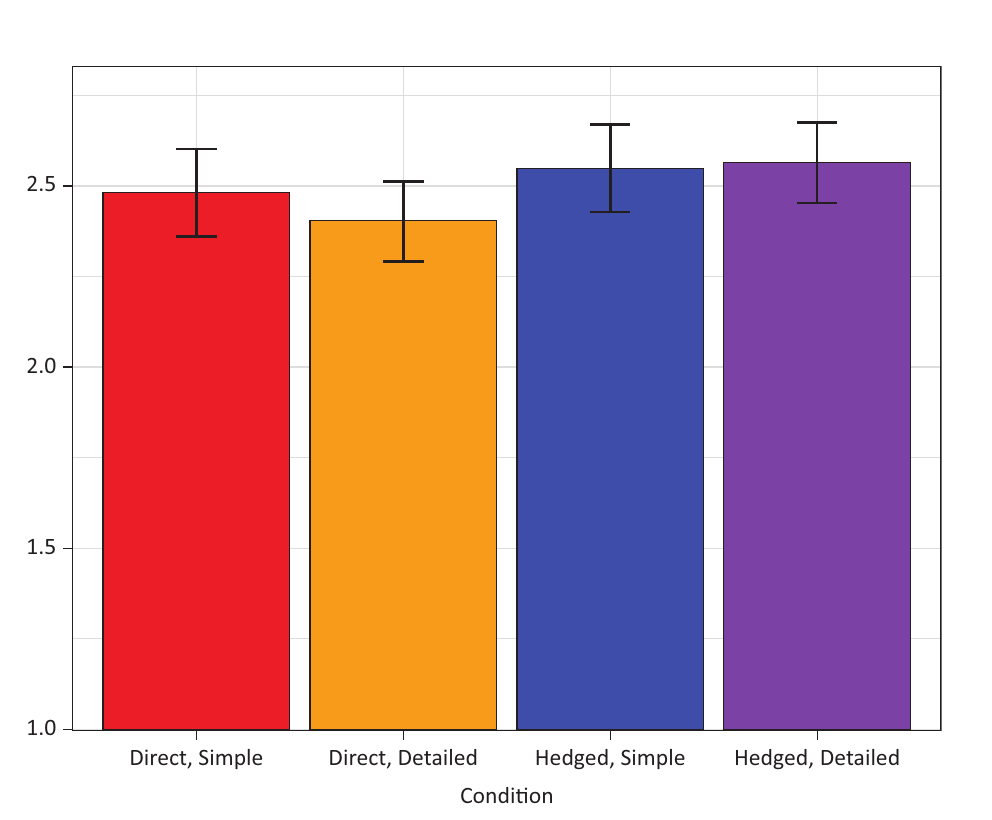
Figure 4. Average aggregated acceptance of corrective information (1–7 Likert-scale) by condition. Notes: N = 1,589. Error bars reflect 95% confidence